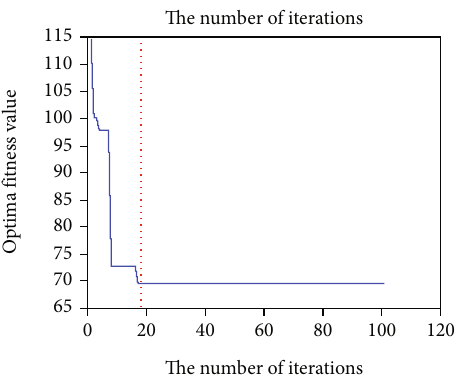
Figure 10: The relationship between the optimal fi tness function and the number of iterations in the ACA hybrid algorithm.